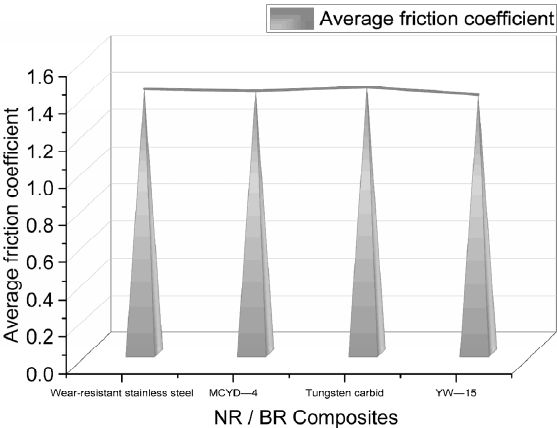
Figure 9. The average friction coefficient of NR/BR composites after friction with different metals. The friction coefficient is mainly related to the dispersion of SiO 2 particles in NR/BR composites and small metal particles. Generally speaking, the better the distribution of SiO 2 particles, the smaller the number of small metal particles, the smaller the friction of NR/BR composites on metal, and the smaller the friction coefficient. The average friction coefficient of the same NR/BR composite material with different metals is different, which mainly depends on the wear resistance of the metal. After the friction of NR/BR compo- sites with metal, the small metal particles on the metal surface are worn off due to abrasive wear caused by rubber. The filler dispersion is affected by incorporating small metal par- ticles into the compound. Therefore, due to the different wear resistance of other metals, the number of small metal particles lost after friction with NR/BR composites is different. Generally speaking, the higher the number of small metal particles, the more serious the obstruction of SiO 2 dispersion in NR/BR composites. Therefore, it can be seen from Figure 9 that the NR/BR composites have the most metal particles after friction with the tungsten carbide alloy, and the NR/BR composites have the smallest metal particles after friction with the YW-15 alloy.